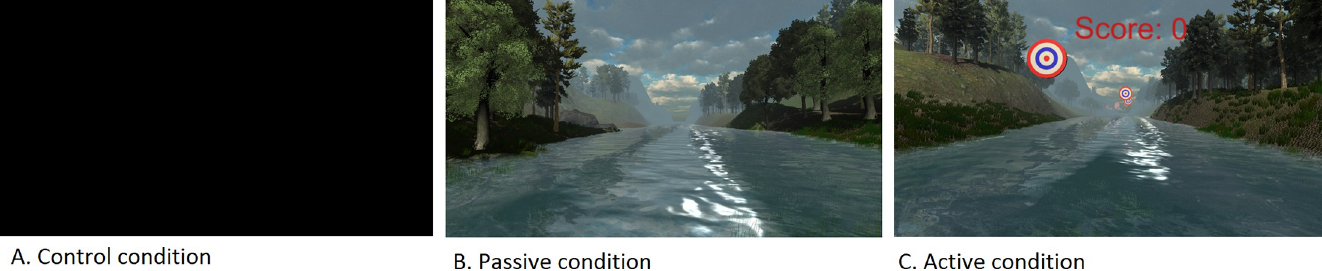
PLOS ONE | https://doi.org/10.1371/journal.pone.0208405 December3,